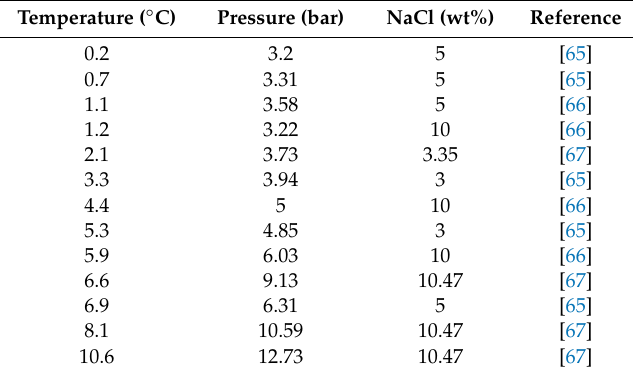
Table 12. Methane hydrate equilibrium data in presence of NaCl, currently available in the